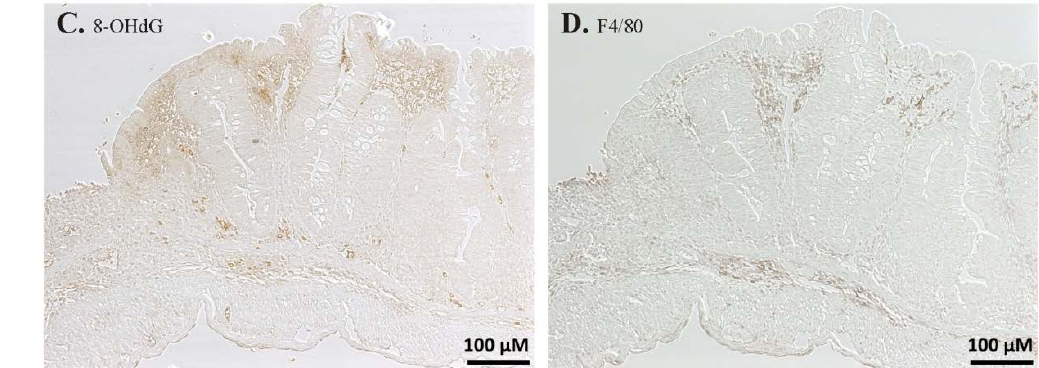
Figure 8. Markers of oxidative stress are unaffected by selenite feeding. ( A ) NQO1 activity was measured in homogenates of the colon. Data are shown as the mean + SD. n = 12. ( B ) 8-OHdG staining intensity of epithelial cells was scored in six representative animals per group. Each point represents one mouse. Lines indicate means. Colon Swiss rolls were stained immunohistochemically with ( C ) anti-8-OHdG antibody and ( D ) anti-F4/80